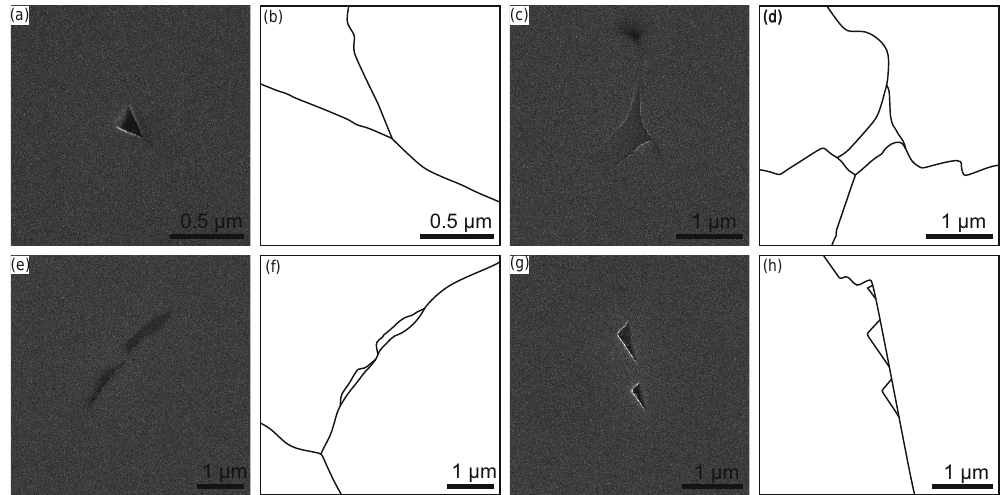
Figure 3. Secondary electron images showing preferred locality of cavities in fine-grained ultramylonite (a, c, e, g) . The sketches represent grain boundary drawings of the areas, respectively (b, d, f, h) . (a, b) Small cavity at grain boundary triple junction. (c, d) Cavity located at four-grain junction. (e, f) Grain boundary opening at grain boundary in extension. (g, h) Small cracks showing the same orientation, piling up at the grain